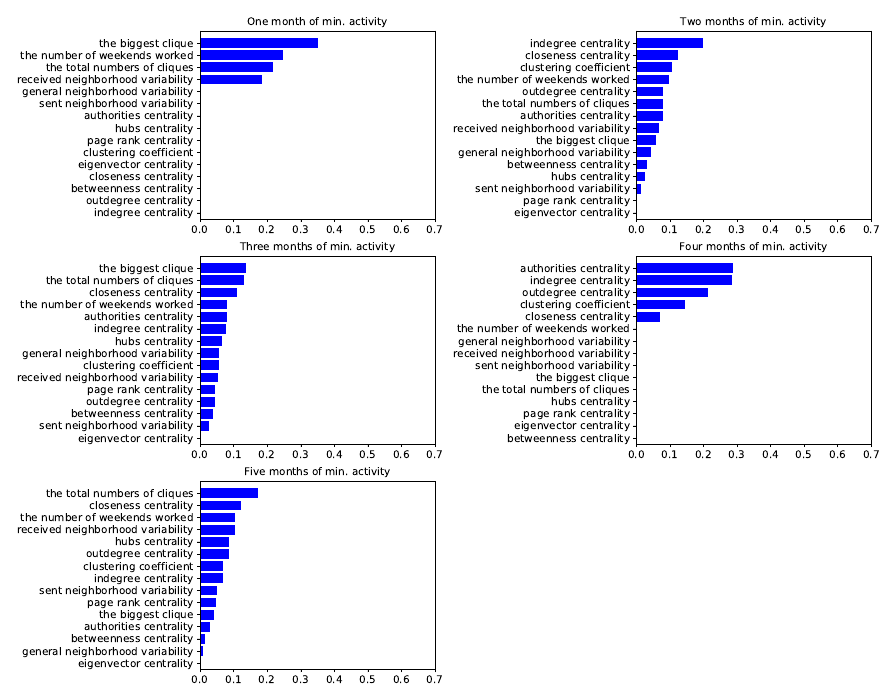
Figure A10. Features importance (Gini importance) for the Random Forest which uses the full set of features for the Enron dataset with three levels of the